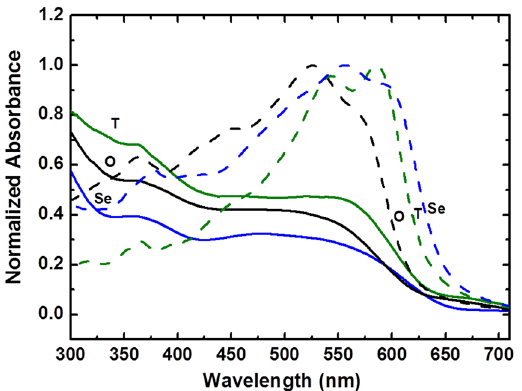
Figure 2. Normalized UV-Vis absorption spectra of the PBDTfDTBX (X = O, T, Se) polymers (dashed lines) and PBDTfDTBX:PC[70]BM blends (solid line). The black, blue and olive lines are the spectra for X = O, T(Sulphur), Se forms of PBDTfDTBX